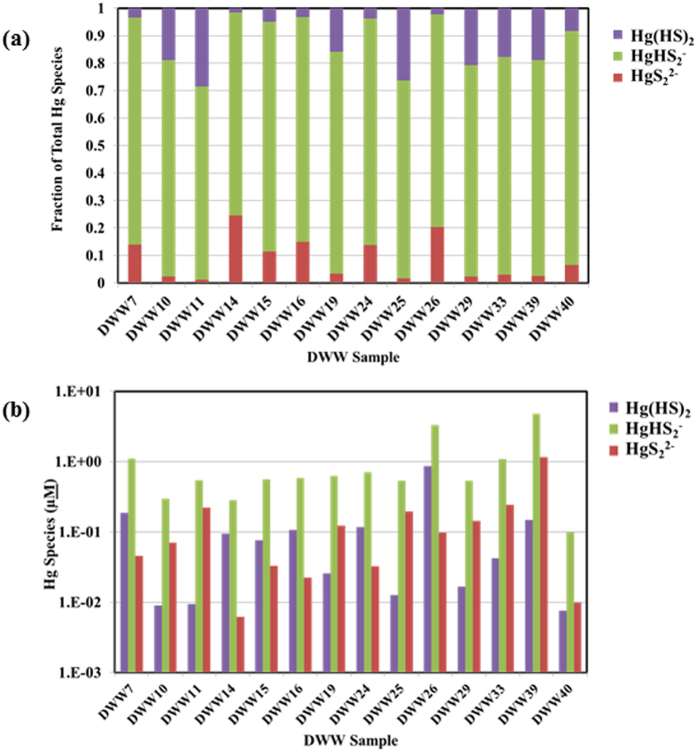
Speciation modelling in DWW samples.(a) Fraction of total Hg species, and (b) Hg species as predicted by equilibrium Hg geochemical speciation modeling in DWW samples.